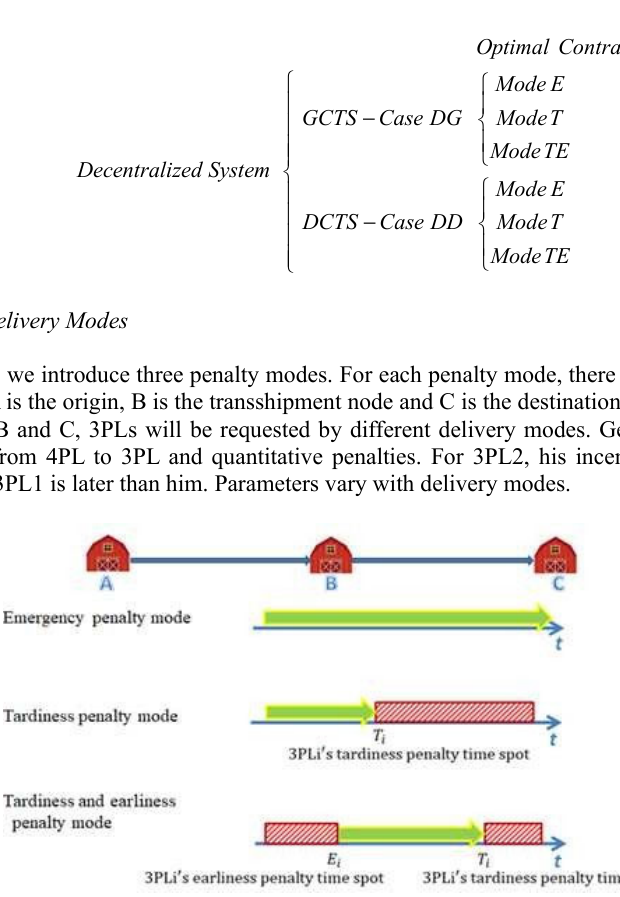
Fig. 10. Delivery modes in the decentralized